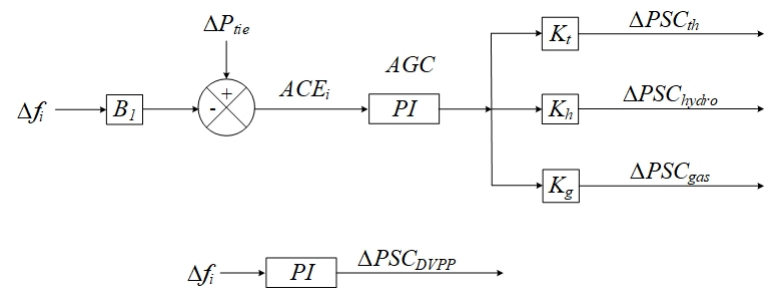
Figure 2. Indirect participation of DVPPs in